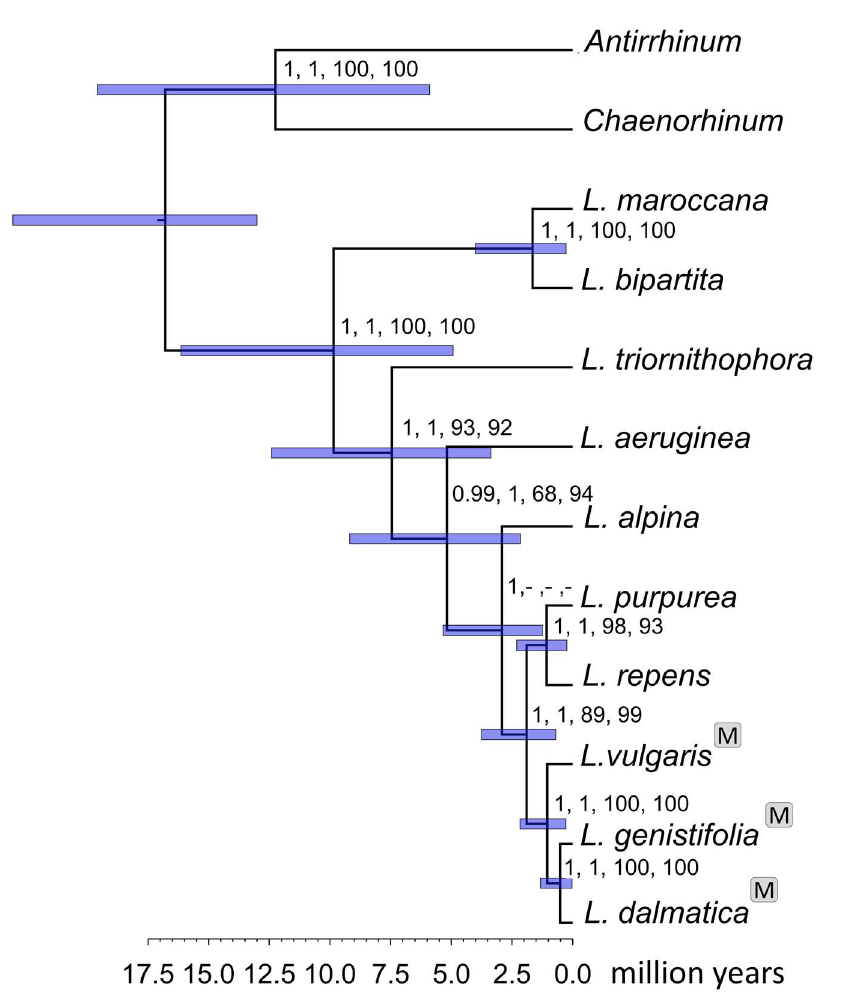
Figure 3. Test of the monophyletic origin of mis insertion in the genus Linaria . The chronogram is based on the nuclear sequence dataset. The species carrying the mikimopine synthase gene are labelled by the M letters in a grey box. The support values for each node are listed as follows: posterior probability obtained in Beast 1.7.5, posterior probability obtained in MrBayes 3.2, bootstrap value obtained in GARLI 2.0, and bootstrap value obtained in PAUP 4.0. (The posterior probabilities are not shown if they are lower than 0.8 and the bootstrap values are not shown if they are lower than 60.) The horizontal bars represent 95% HPD (highest posterior density) intervals of node ages in million